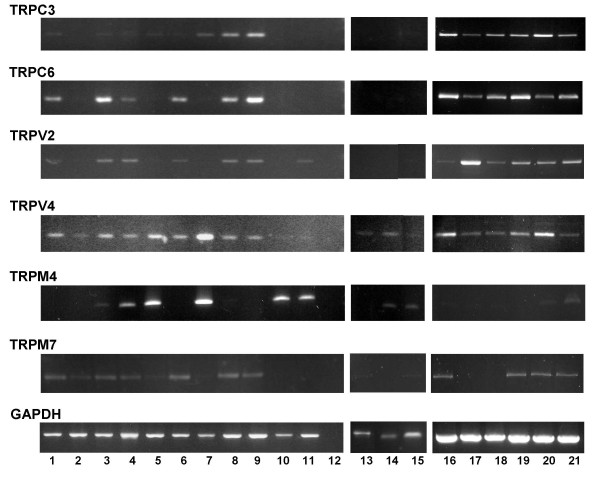
Expression of TRP channel mRNAs in murine tissues using standard RT-PCR. Reverse transcribed RNA (8 ng) from tissues of adult (100 d) C57Bl/10SC mice was added to the reaction mixtures and PCR products amplified in 40 cycles. The products were separated on agarose gels and stained with ethidium bromide. Water served as negative control. 1) testis; 2) liver; 3) lung; 4) spleen; 5) skeletal muscle; 6) epididymis; 7) kidney; 8) ovary; 9) seminal vesicle; 10) uterus; 11) C2C12 cells; 12) H2O; 13) aorta; 14) intestine; 15) heart; 16) hippocampus; 17) brain stem 18) forebrain; 19) cerebrum 20) cerebellum; 21) truncus encephali.